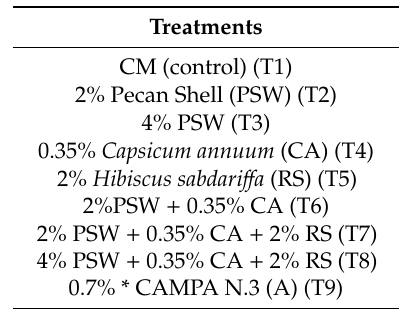
Table 1. Formulations for the beef